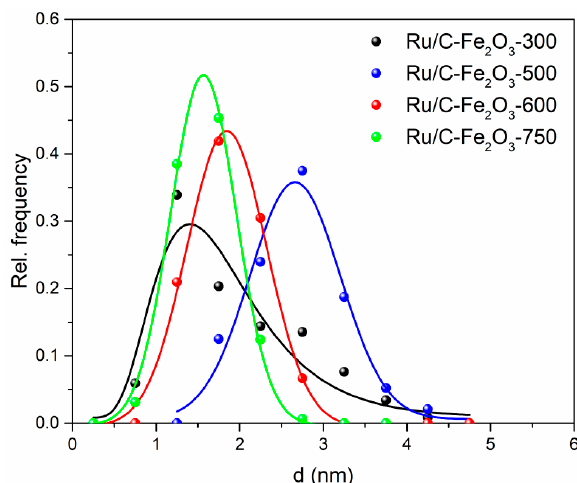
Figure 2. Transmission electron microscopy (TEM) images of catalysts ( a , b ) Ru/C-Fe 2 O 3 , ( c , d ) Ru/C- Fe 2 O 3 -300, ( e , f ) Ru/C-Fe 2 O 3 -500, ( g , h ) Ru/C-Fe 2 O 3 -600, and ( i , j ) Ru/C-Fe 2 O 3 -750. An Ru nanoparticle is marked with the arrow ion the image (b).